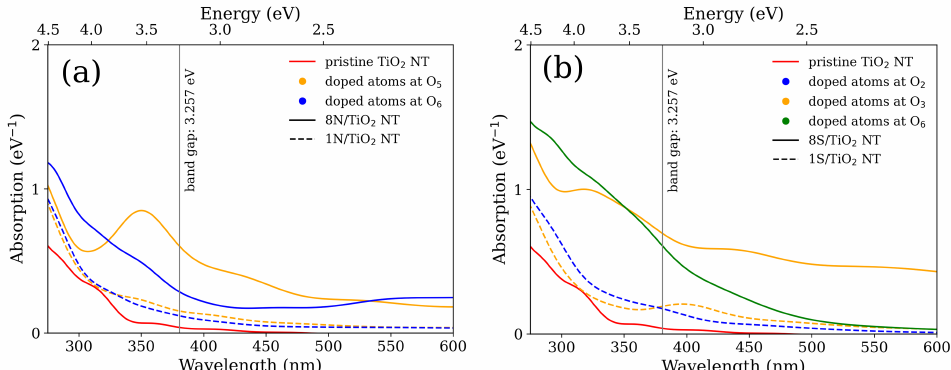
Figure 3. Absorption spectra of ( a ) N- and ( b ) S-doped TiO 2 NTs. The red line is the absorption spectrum of the pristine TiO 2 NT. The solid lines correspond to the 8N/TiO 2 - and 8S/TiO 2 -doped scenario (Figure 2), while the dashed lines are for the single atom doped NTs. For N-doped TiO 2 NTs ( a ): the orange color is for the dopant placed at the O 5 position and the blue color is for the dopant placed at the O 6 position. For S-doped TiO 2 NTs ( b ): the orange color is for the dopant placed at O 3 position; the blue color is for the dopant placed at O 2 position; and the green color is for the dopant placed at O 6 position. The orange color is for the dopants placed on the inner surface of the NT wall. The blue and green color are for the dopants placed on the outer surface of the NT wall. The position of O n is related to the inset of Figure